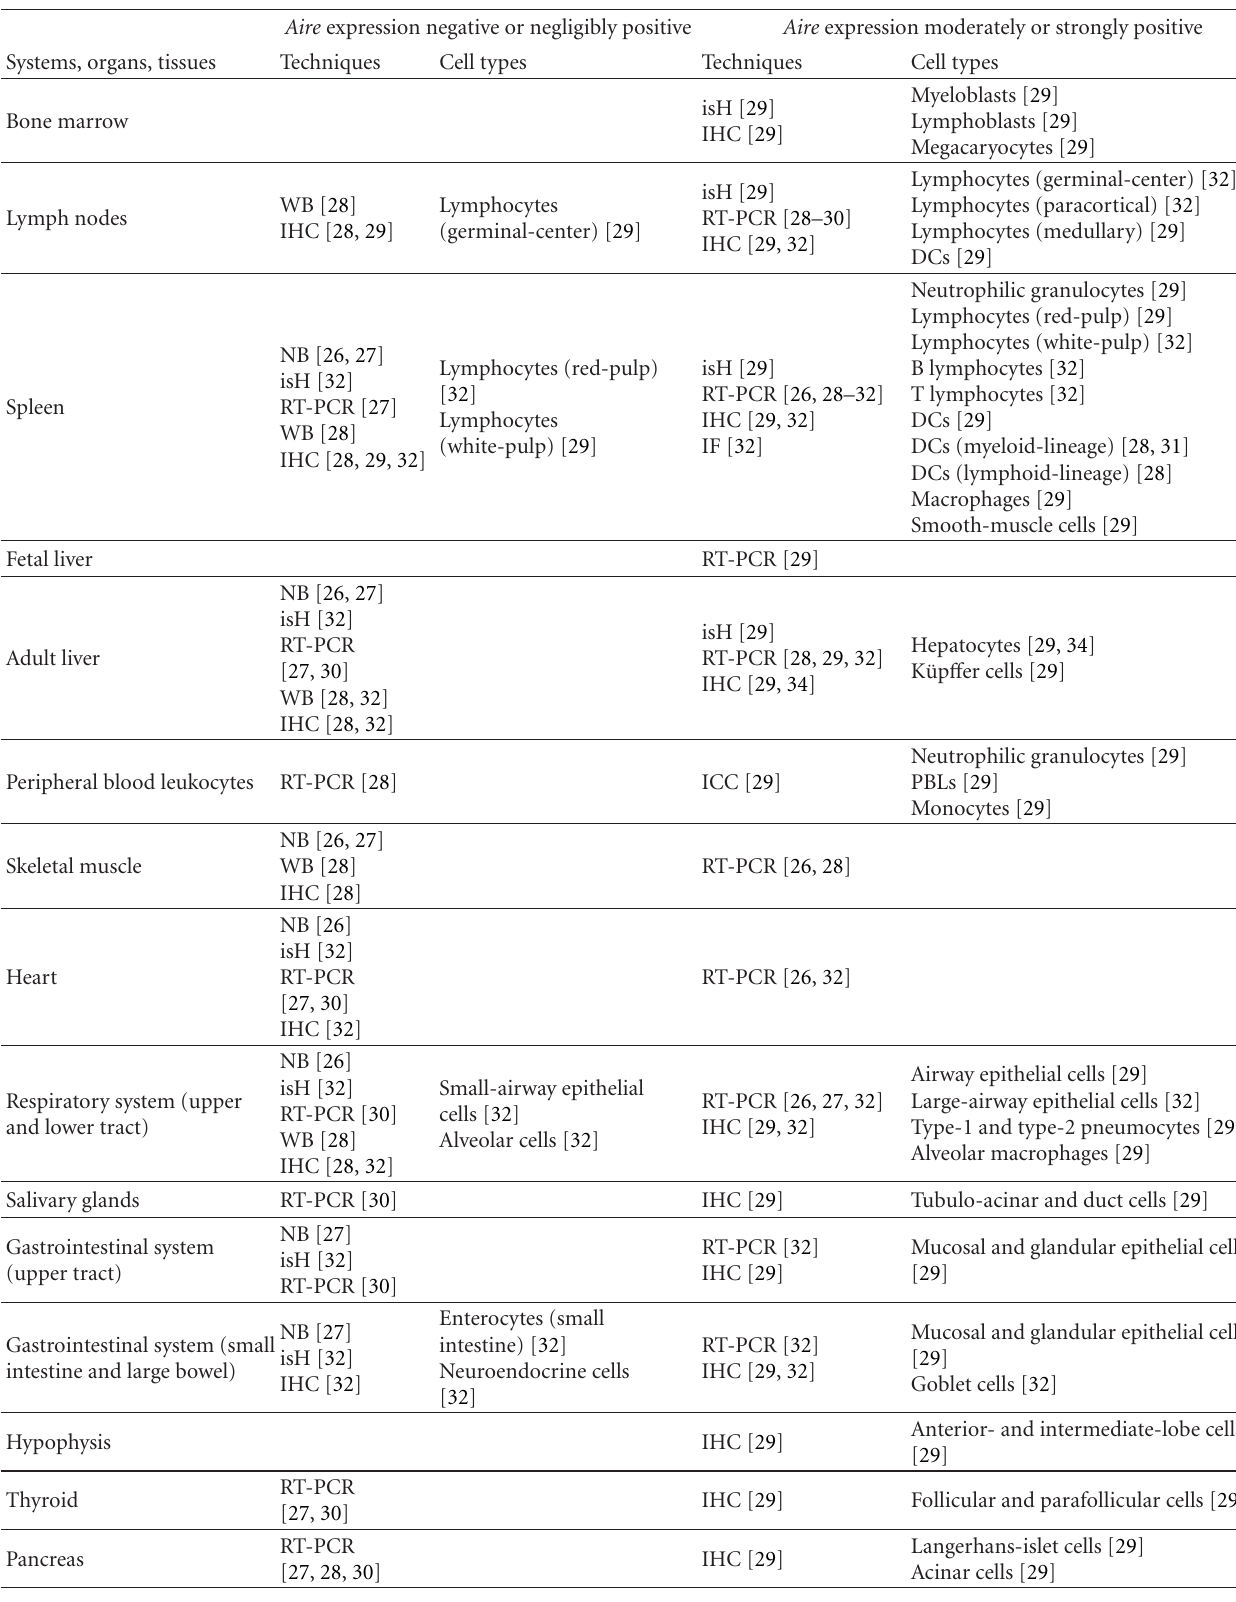
Table 2: Aire expression ( Aire mRNA and Aire protein) in murine extra-thymic systems, organs, and